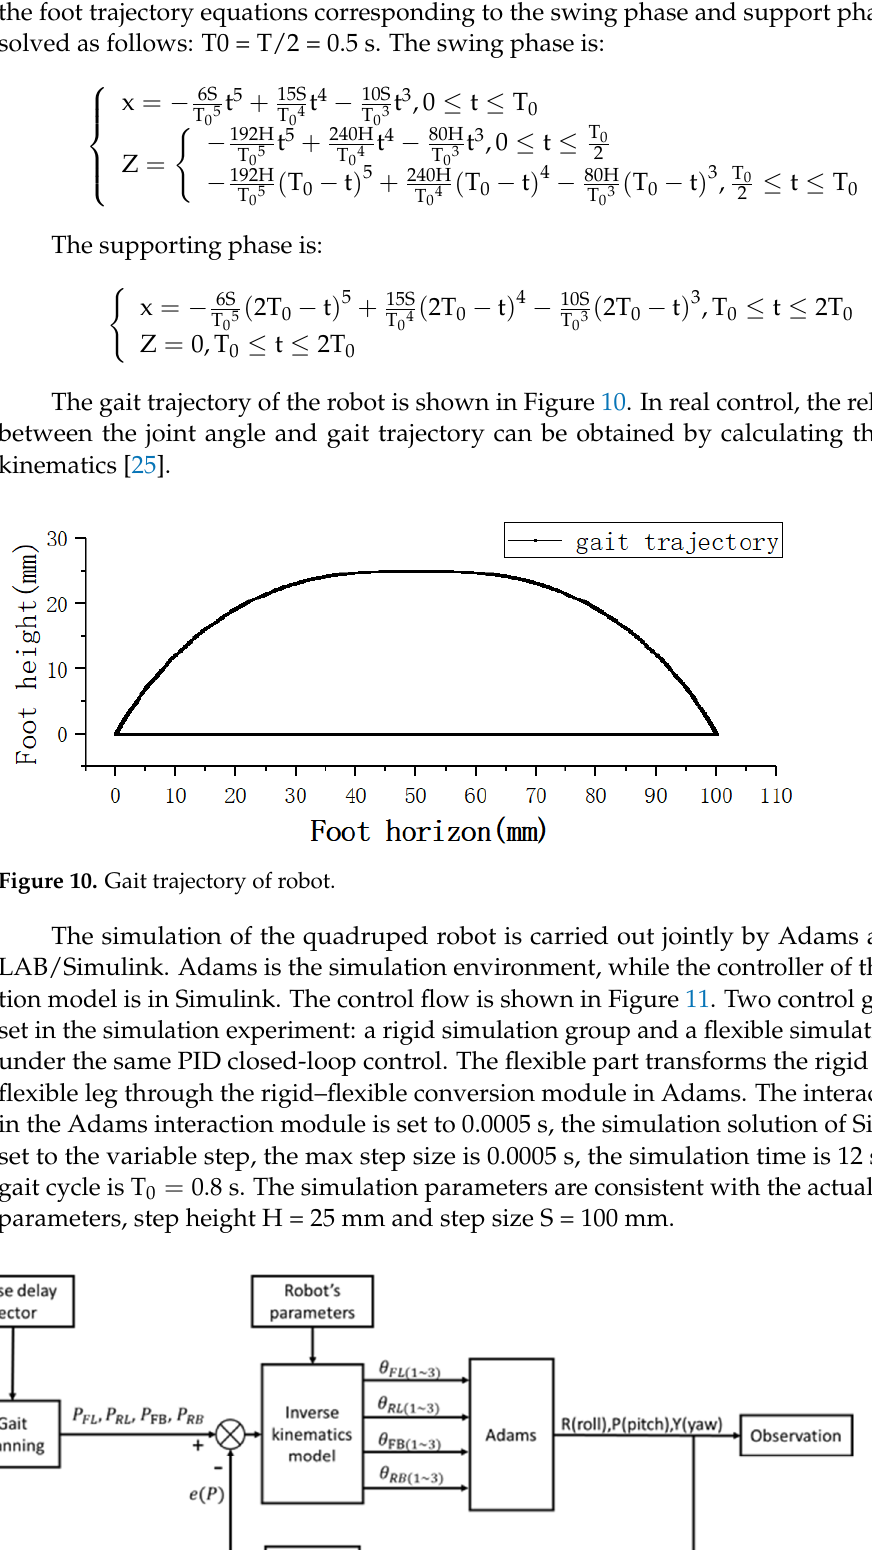
Figure 11. Control flow chart.